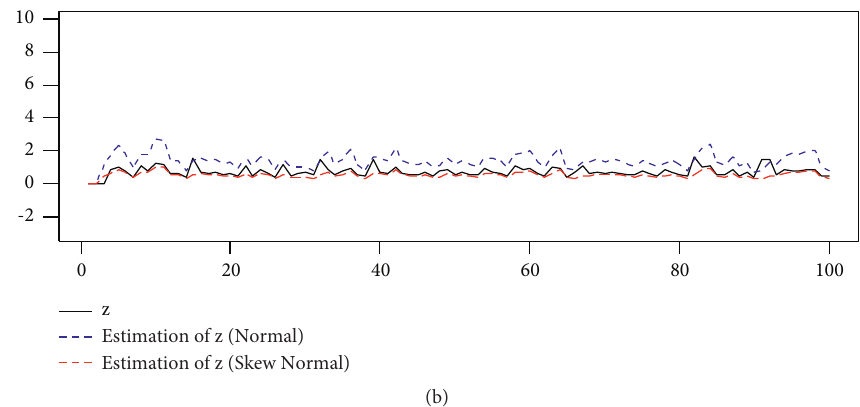
Figure 4: (a) Exact and estimated values of f ( z